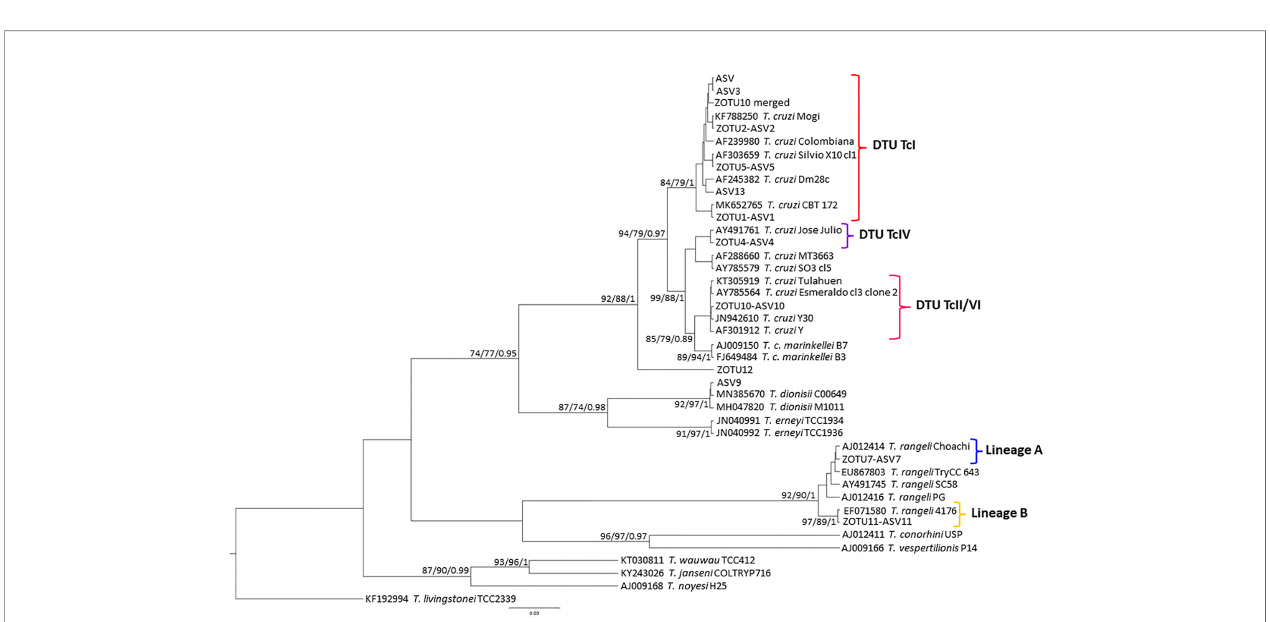
FIGURE 2 | Trypanosoma cruzi clade phylogenetic tree based on 465bp 18S rDNA fragment length from D. albiventris , R. rattus , R. nasutus , and T. brasiliensis culture samples. The tree was inferred with TPM3uf plus gamma distribution among sites (TPM3uf+G) for ML and BI. The number at nodes corresponds to ML (ultrabootstrap and SH-aLRT) and BI (posterior probability). The scale bar shows the number of nucleotide substitutions per site. The red bracket indicates the group formed by T. cruzi DTU TcI; the lilac bracket indicates the sequences grouped as T. cruzi DTU TcIV; the pink bracket indicates the sequences identi fi ed as T. cruzi DTU TcII; the blue bracket indicates the sequences identi fi ed as T. rangeli lineage A; and the yellow bracket indicates the sequences identi fi ed as T. rangeli lineage